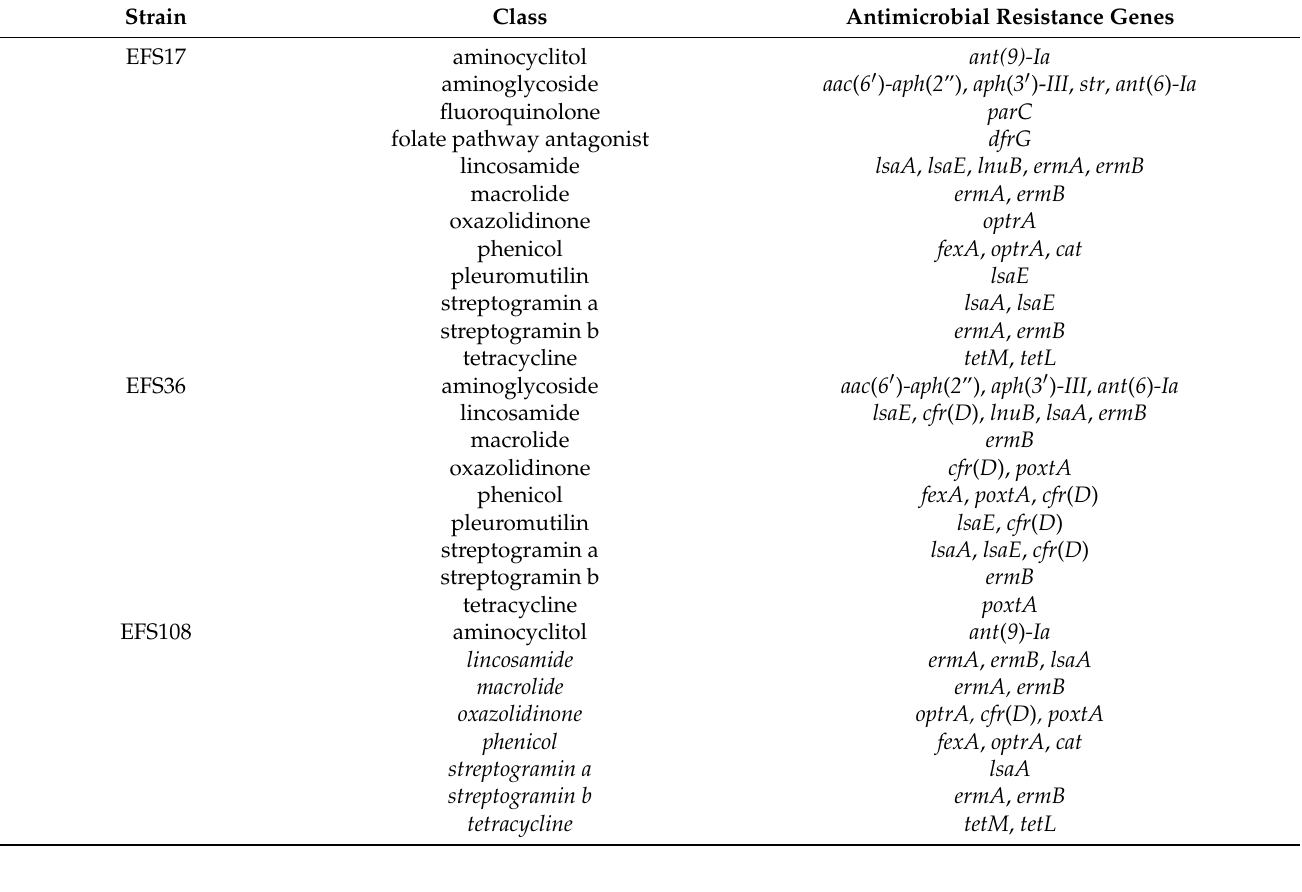
Table 5. Antimicrobial resistance genes in three E. faecalis strains.